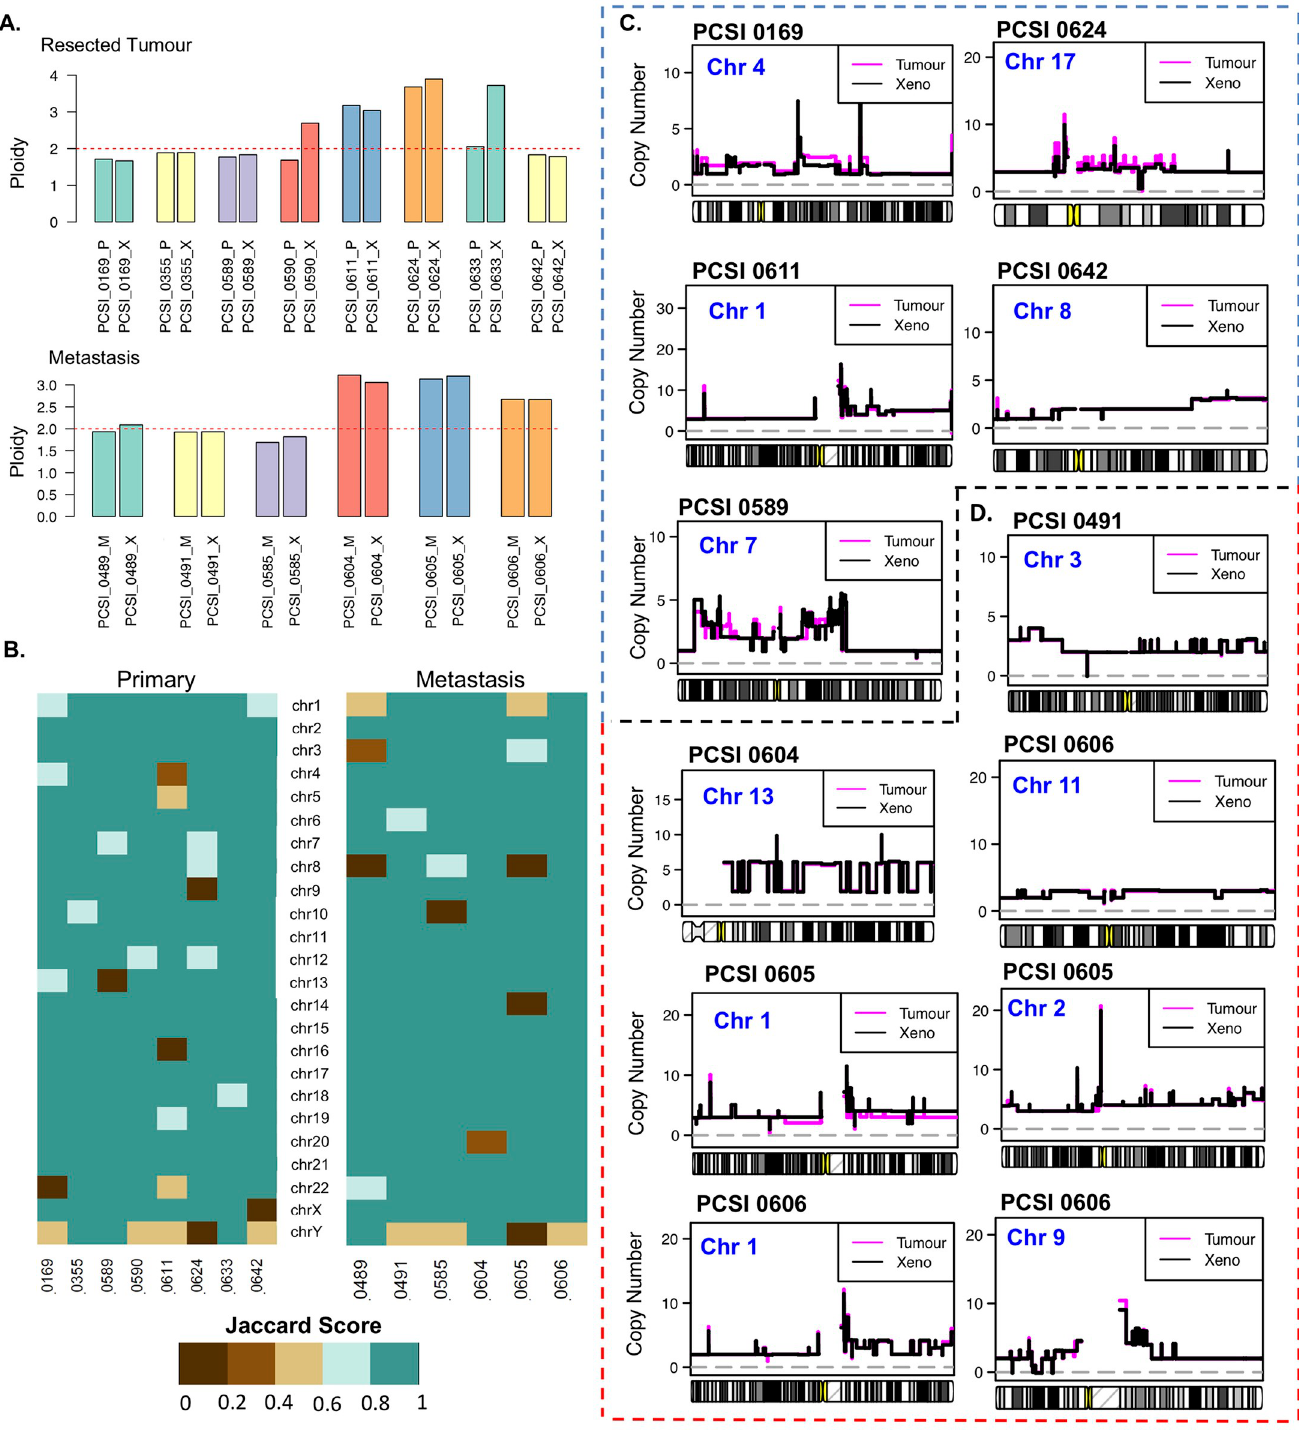
Fig 7. Comparative analysis of copy number state across tumour-PDX pairs of the resected primary cohort. (A) Ploidy across tumour-PDX pairs for primary tumours (top) and liver metastasis (bottom). (B) Chromosome-specific Jaccard indices across 10 primary-PDX pairs (left) and 6 metastasis-PDX pairs (right). (C) Copy number state (uncorrected) of primary tumour (magenta) and matching PDX (black) in primary-PDX pairs, highlighted for chromosomes for which chromothripsis had been observed. (D) Copy number state (uncorrected) of liver metastases (magenta) and matching PDX (black) in metastasis-PDX pairs, highlighted for chromosomes for which chromothripsis had been